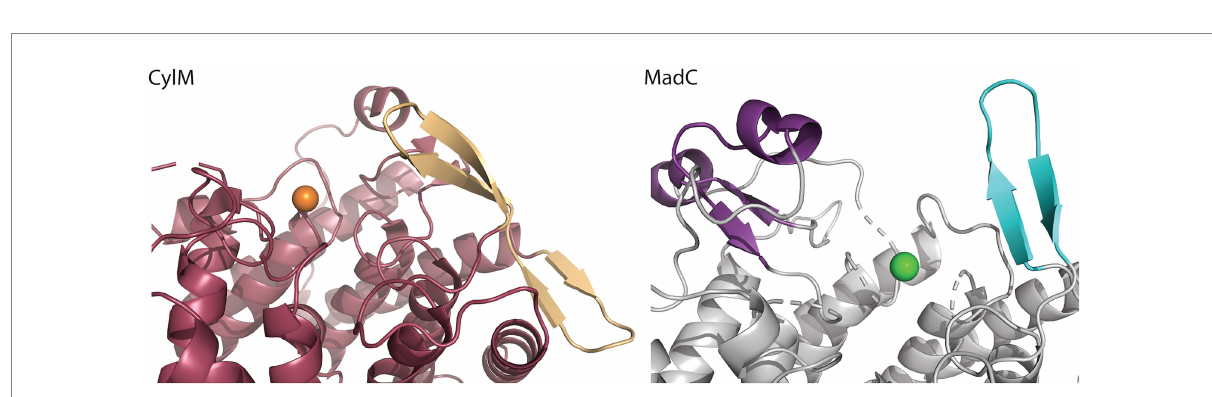
FIGURE 4 Comparison of the β -sheet domain of class I LanC’s and class II cyclization domain. In the zoom-in of the cyclase domain of CylM (residues 624– 992 of CylM, PDB: 5DZT) the structure is colored in dark red except of the β -sheet domain (colored beige) close to the zinc ion (orange sphere). The α , α -toroid structure of MadC (PDB:8BYK) is shown in grey and the β -sheet close to the zinc ion (green sphere) is highlighted in cyan. The SH2-like domain is highlighted in